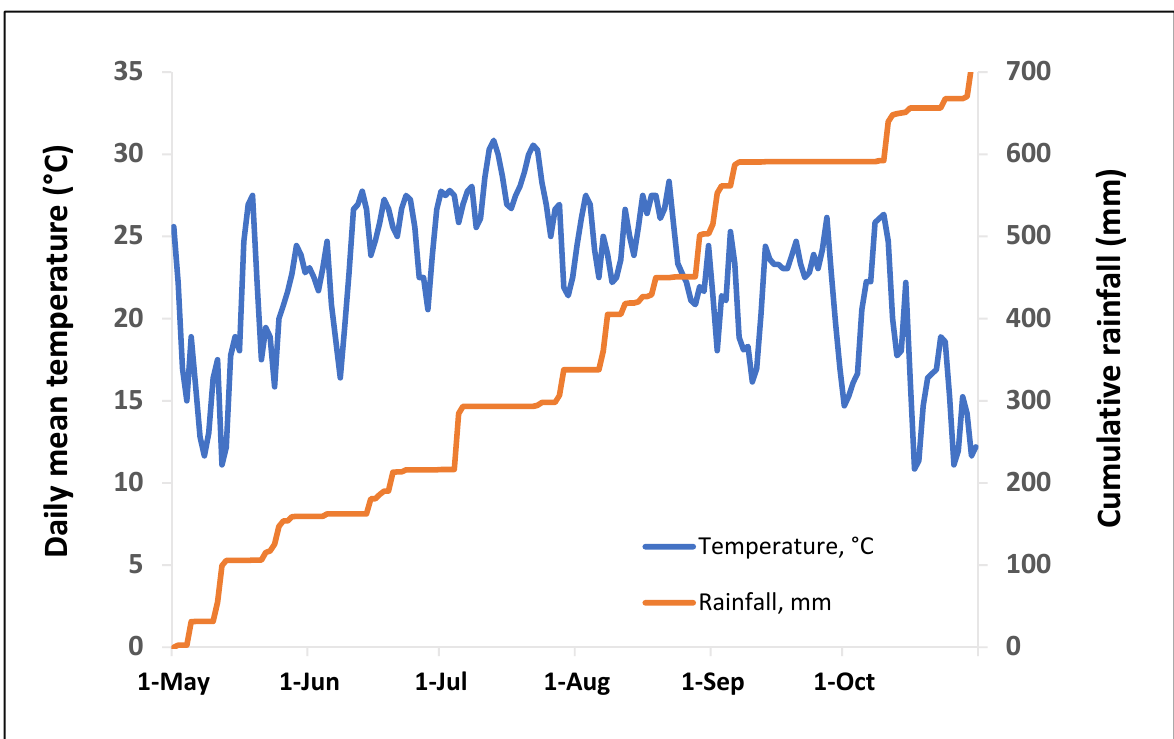
Figure 3. Total accumulated rainfall (in mm) and daily mean air temperature (in °C) for the period May through October 2017, in New Kent, VA. Source: National Oceanic and Atmospheric Administration, National Climate Data Center (https://www.ncdc.noaa.gov; 1 January 2022).